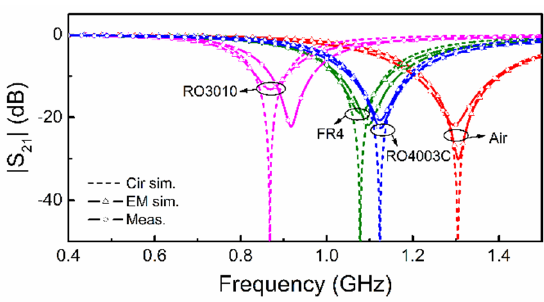
Figure 9. Experimental validation. The dielectric constant of the considered samples is 10.2 ( Rogers RO3010 ), 4.4 (FR4), 3.55 ( Rogers RO4003C ) and 1 (air), with 4 pieces of the slabs stacked together (around 4 mm) for each type of